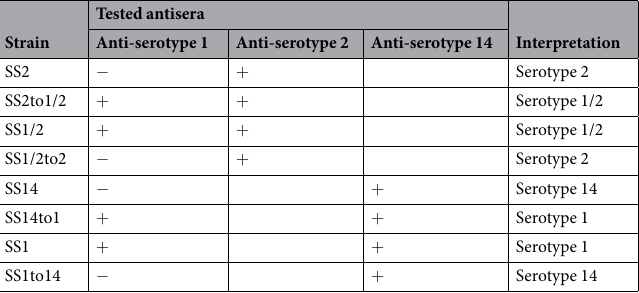
Table 1. Results of the coagglutination